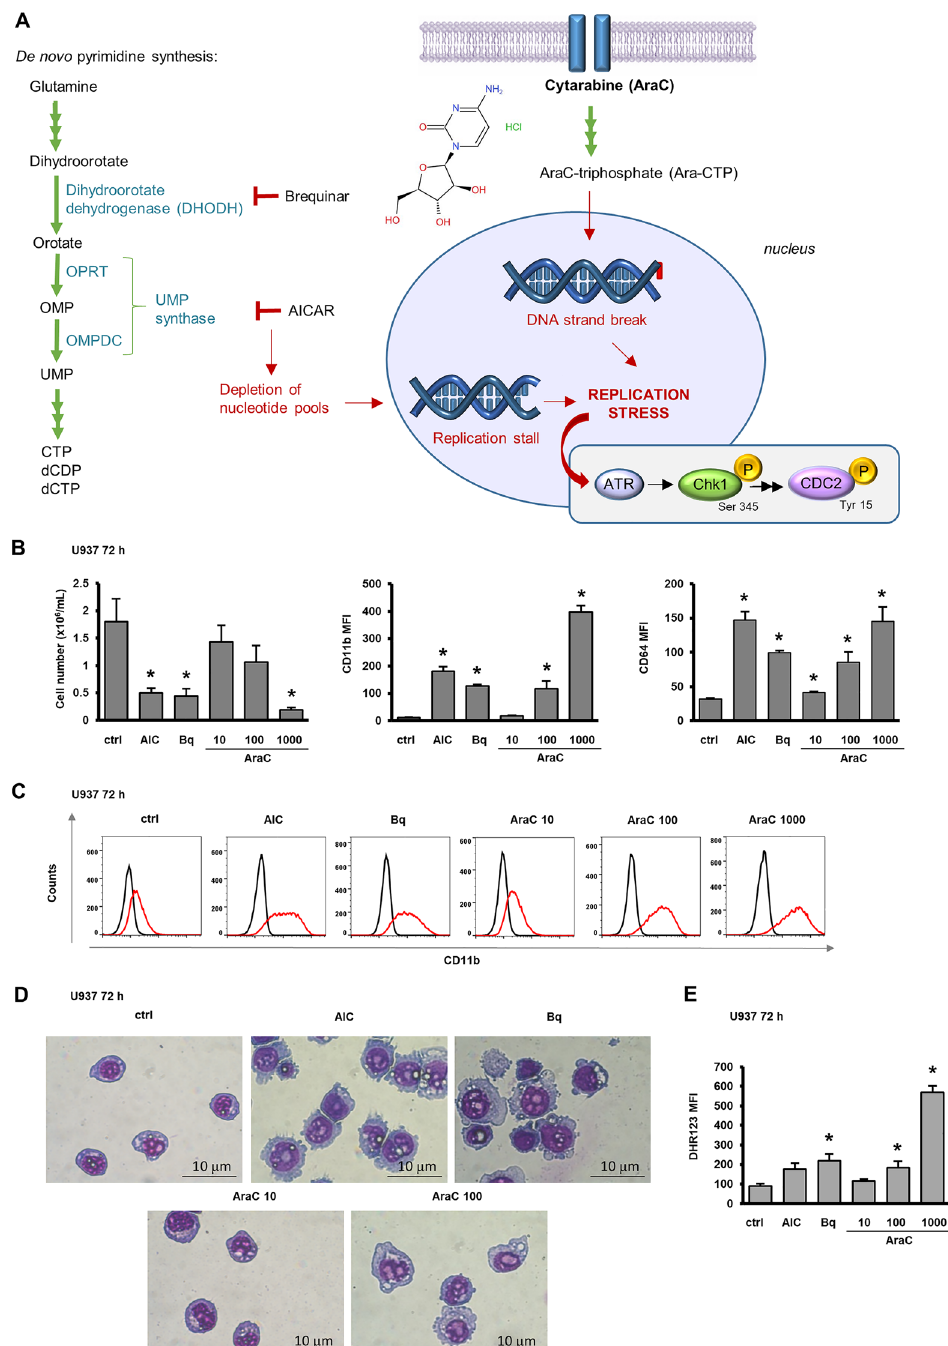
Figure 1. Cytarabine dose-dependently decreases cell number and induces differentiation. ( A ) DNA damage pathway activation by pyrimidine synthesis inhibitors and cytarabine. ( B ) U937 cells were incubated with AICAr (AIC) (0.2 mM), brequinar (Bq) (0.5 µM) and AraC (10, 100, 1000 nM). The number of viable cells and the expression of differentiation markers were determined after 72 h. Mean fluorescence intensity (MFI) of CD11b and CD64 was calculated as described under “Methods” section. Results are mean ± S.E. (error bars) of at least three independent experiments. *, p < 0.05 (Student’s t -test) compared with control (ctrl). ( C ) Representative histograms (out of three independent flow cytometric analyses shown in B) with black line representing isotypic control and red line representing the expression of CD11b. ( D ) Morphological analysis of U937 cells treated with AICAr (AIC) (0.2 mM), brequinar (Bq) (0.5 µM) and AraC (10 and 100 nM). May- Grünwald-Giemsa stained cytospin preparations (100 × magnification). (E) Respiratory burst in U937 cells treated with AICAr (AIC) (0.2 mM), brequinar (Bq) (0.5 µM) and AraC (10, 100, 1000 nM) for 72 h. Results are mean ± S.E. (error bars) of at least three independent experiments. *, p < 0.05 (Student’s t-test) compared with control